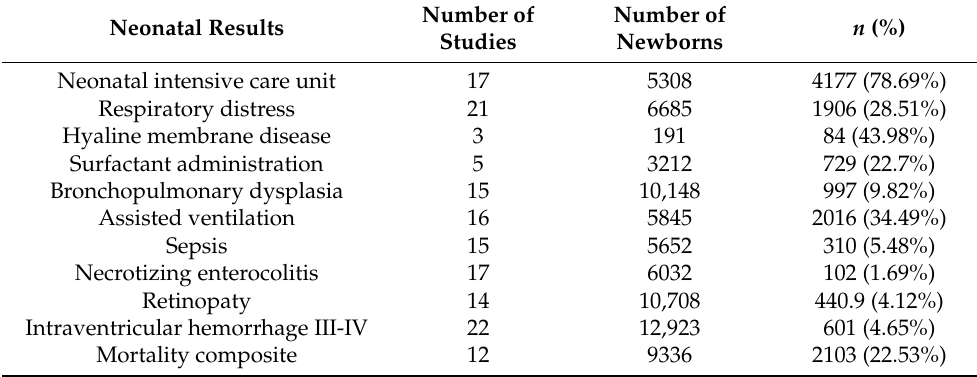
Table 5. Neonatal results of the triplet pregnancies included in the systematic review.